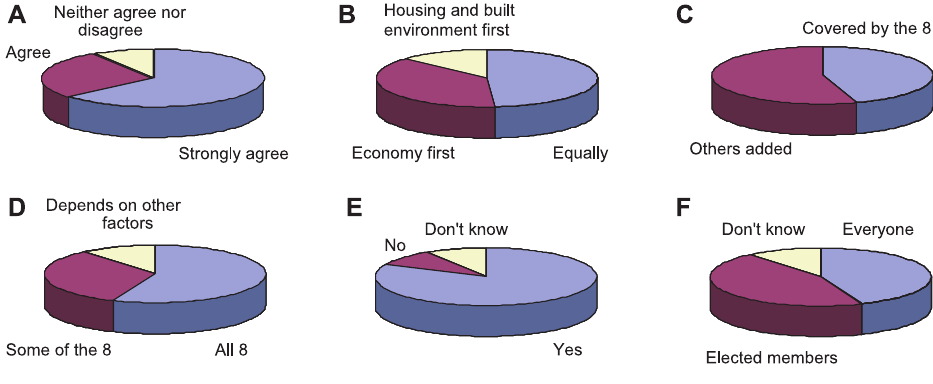
Fig. 3. Sustainable communities and its 8 key components. The pie charts denote the proportion of responses against each interview question. Charts A-F represents responses to the following questions: (A) The government defines sustainable communities as places where people want to live and work, now and in the future (Office of the Deputy ... 2003). How can sustainable communities be defined? (B) The government refers to 8 key components of sustainable communities: governance, transport and con- nectivity, services, environmental, equity, economy, housing and built environment, social and cultural. How can they be ranked in terms of importance? (C) What are the key components in making sustain- able communities? Are they different to the governments 8, would you add others? (D) Is it necessary to have all 8 key components or some of them will be enough? (E) Would the good economic situation in the community help making it a sustainable community? (F) Do members of the community have to be involved in delivering sustainable